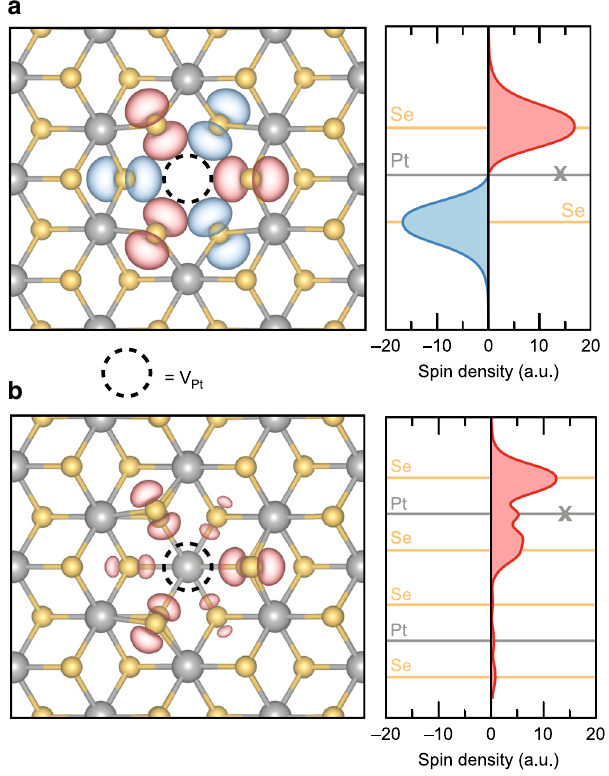
Fig. 4 Localized magnetic moments at Pt vacancy defects in PtSe 2 . a Spin-density distribution at the ground-state con fi guration of the V Pt defect in monolayer PtSe 2 calculated from fi rst principles. Gray and orange balls represent Pt and Se atoms, respectively. The red and blue isosurfaces correspond to positive and negative spin densities. The position of the missing Pt atom is marked with a dashed circle. The right panel shows the in-plane averaged spin density as a function of the out-of-plane position. The cross (X) indicates the Pt atomic plane at which the vacancy defect is introduced. b Spin-density distribution at the Pt vacancy in the top layer of bilayer PtSe 2 calculated from fi rst principles. Units in panels ( a ) and ( b ) agree with each